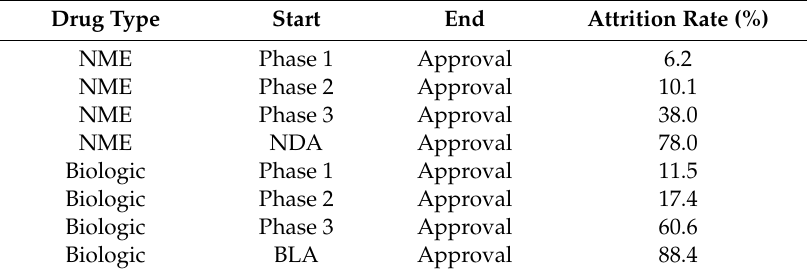
Table 1. POS in the development phase of drugs classified by drug